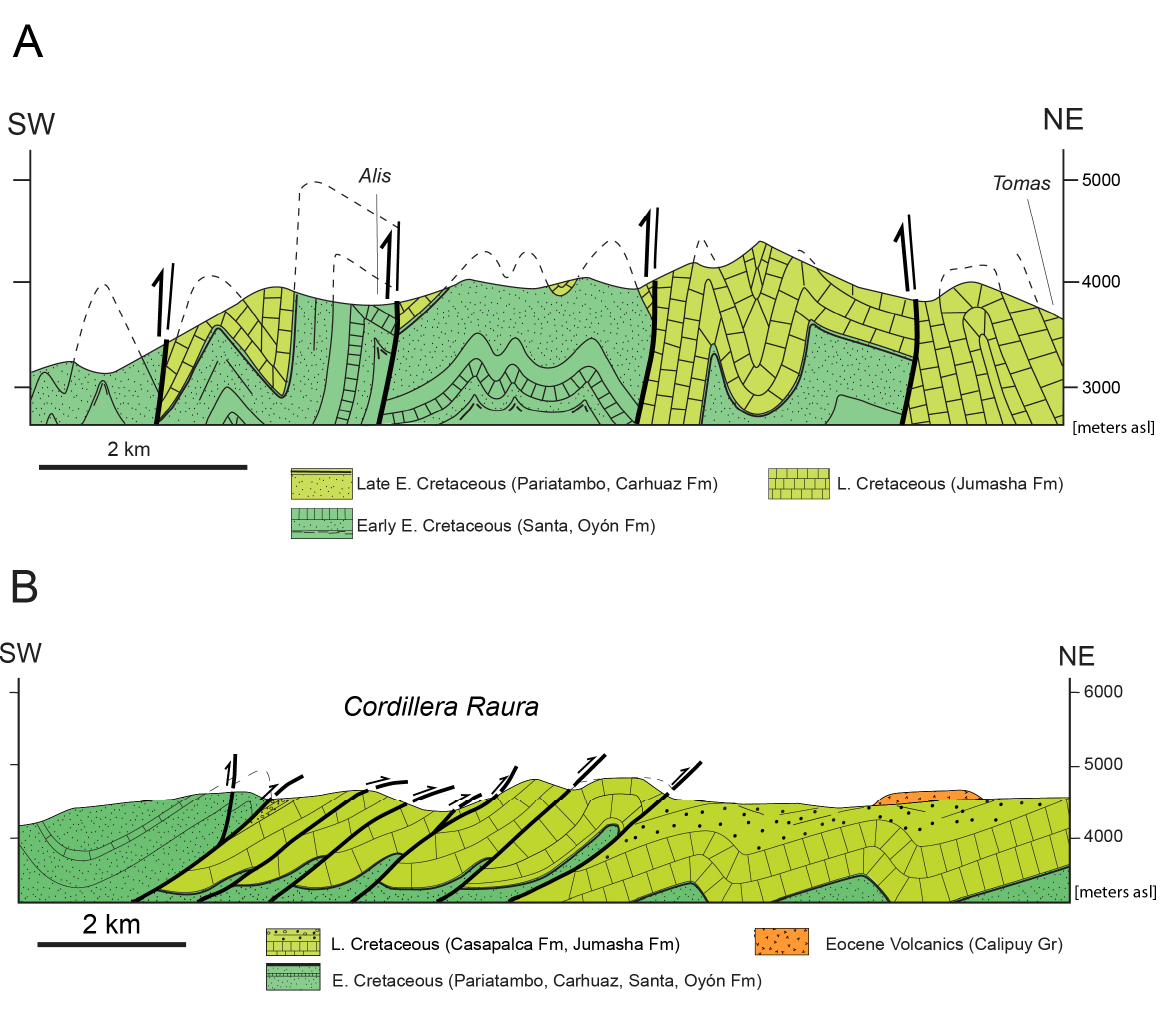
Figure 9. Two cross-sections in the Western Cordillera showing the structural style within the Marañon fold-and-thrust belt. Traces are given in Figure 7. ( A ) Tight folds and steeply inclined thrust faults in the flanks of the Rio Cañete Canyon between Tomas and Alis; ( B ) Imbricate thrusting in the Cordillera